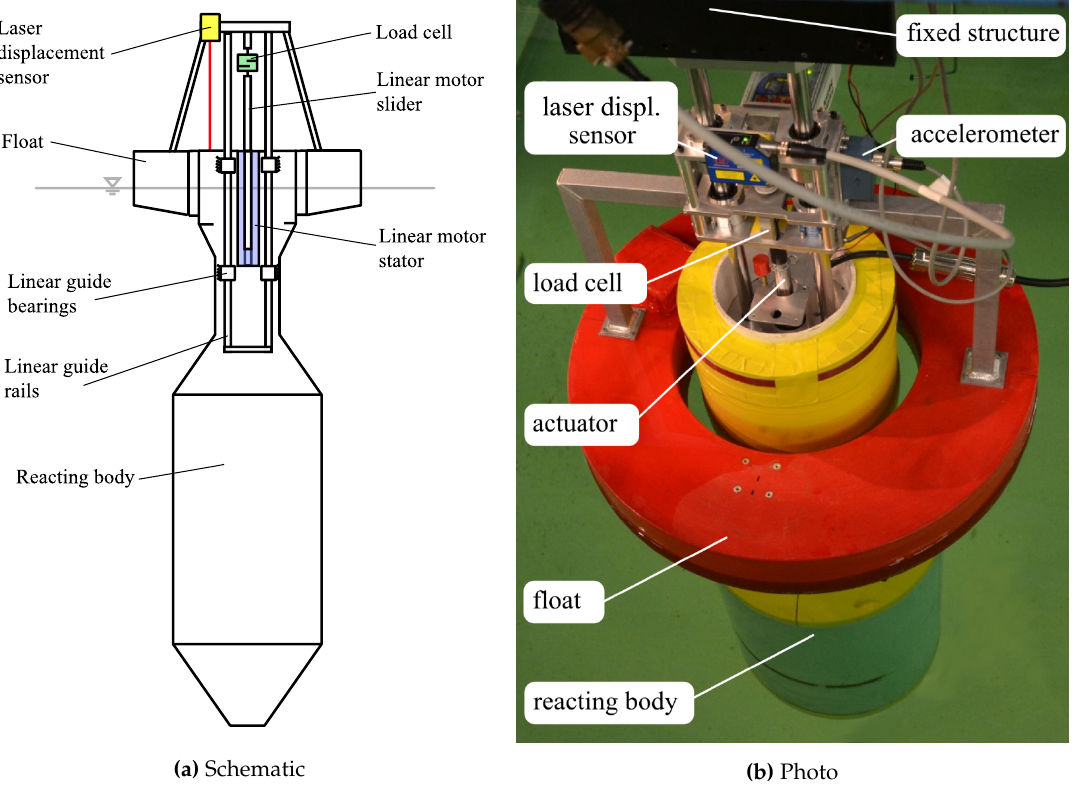
Figure 1. 1:25 scale two-body point absorber WEC with PTO simulator